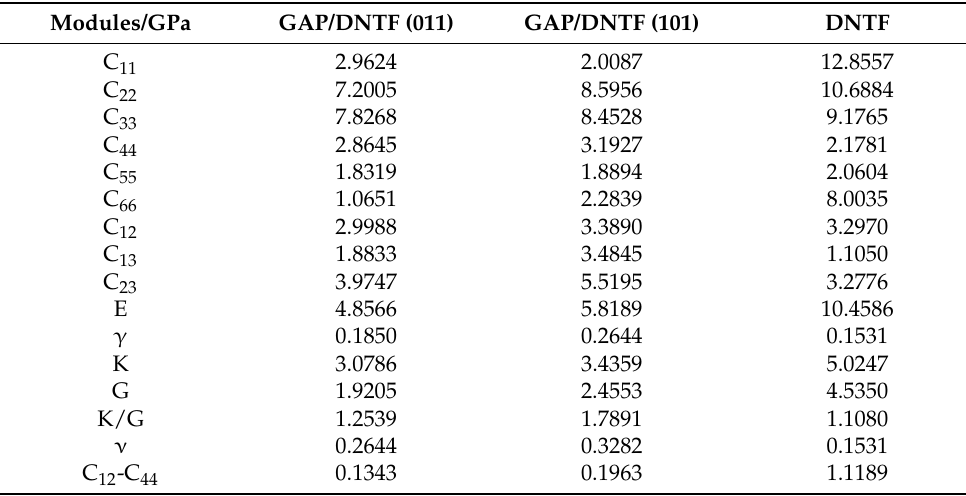
Table 4. Mechanical properties of different GAP and DNTF crystal